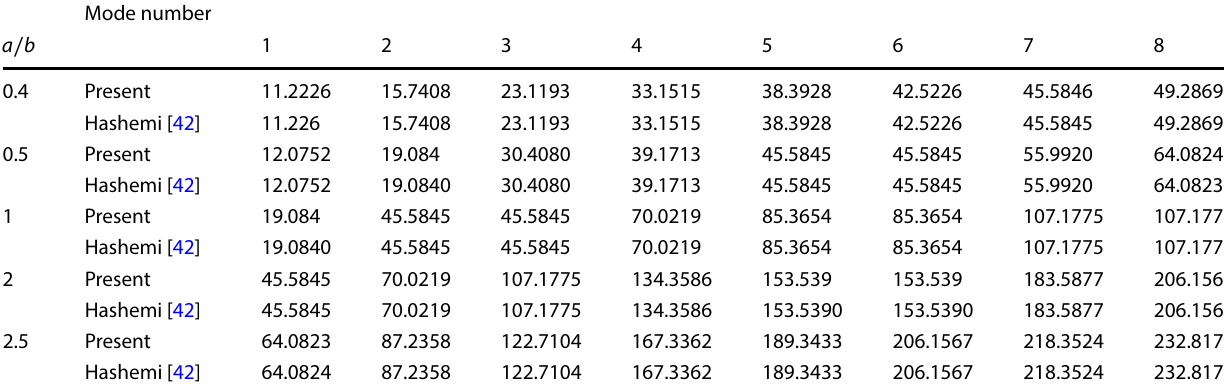
Table 2 The first eight linear dimensionless natural frequencies of a homogenous rectangular plate for various (a/b) compared with Ref [42] for SSSS boundary condition